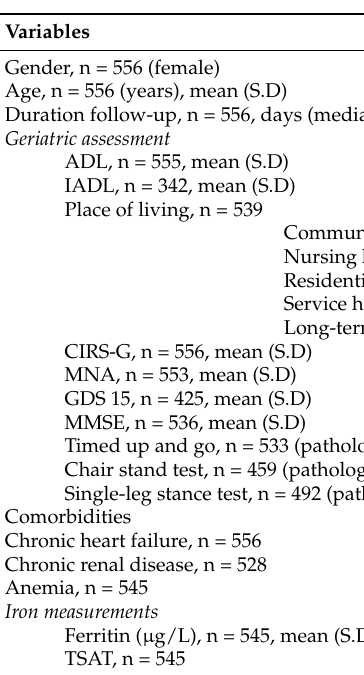
Table 1. Patient characteristics at